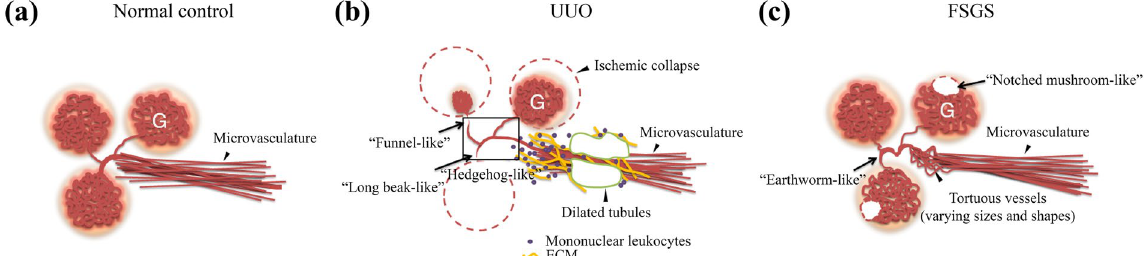
Figure 7. Hypothesized pathogenic pathways reflected by the images in the two complementary models of chronic kidney disease. ( a ) The normal control mice display relatively intact glomeruli that were evenly distributed in the cortex. ( b ) The UUO (mainly renal TI lesions) mice showed a disrupted configuration and apparent rarefaction of the microvasculature, which was displayed in the hedgehog-like (highlights in square), funnel-like and long beak-like images. ( c ) In FSGS (mainly glomerulopathy) mice, the microvasculature was clearly visible, with the exception of intense, focal twisted microvascular profiles in the renal cortex and the random defects of glomeruli, which are represented by the notched mushroom-like and earthworm-like imaging markers. These schematic diagrams were constructed according to the imaging features and reflected the pathological findings (PAS and IHC staining). UUO-unilateral ureteral obstruction; FSGS-focal segmental glomerulosclerosis; TI-tubulointerstitial; G-glomerulus; ECM-extracellular